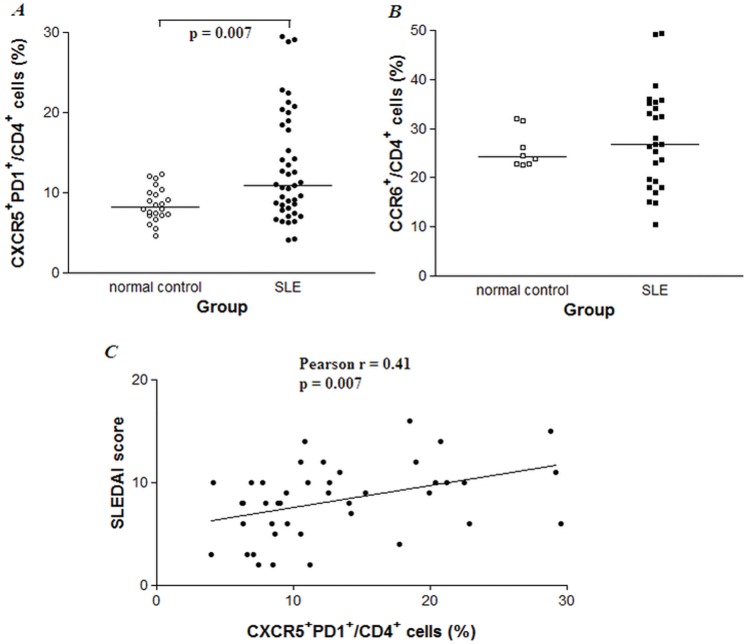
Aberrant circulating CXCR5+ PD1+/CD4+ but not CCR6+/CD4+ T cells correlated with disease activity in SLE patients.A. Elevated circulating CXCR5+ PD1+/CD4+ cells in SLE patients compared to normal controls. PBMCs were quantified by FACS, each symbol represented an individual sample and horizontal lines showed median values. Mann-Whitney U test was conducted to compare the data between two groups. B. Circulating CCR6+/CD4+ cell proportions enriched for Th17-like cells were compared between SLE patients and normal controls. C. Correlation between percentages of CXCR5+ PD1+/CD4+ cells and disease activity of 42 SLE patients. Pearson correlation was applied to depict linear relationships.